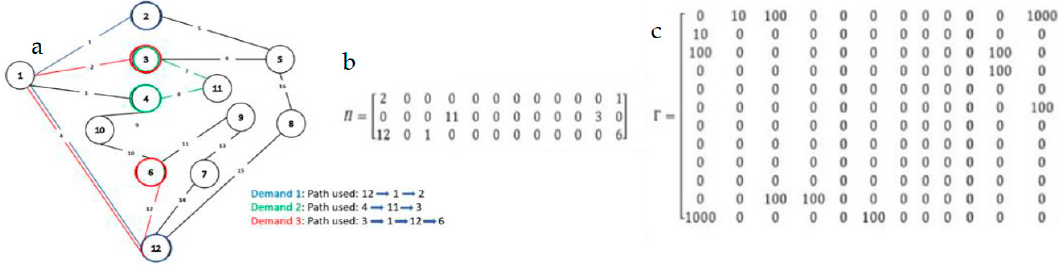
Figure 5. ( a ) Topology (a portion of the GÉANT network); ( b ) A possible data plane; ( c ) control plane.